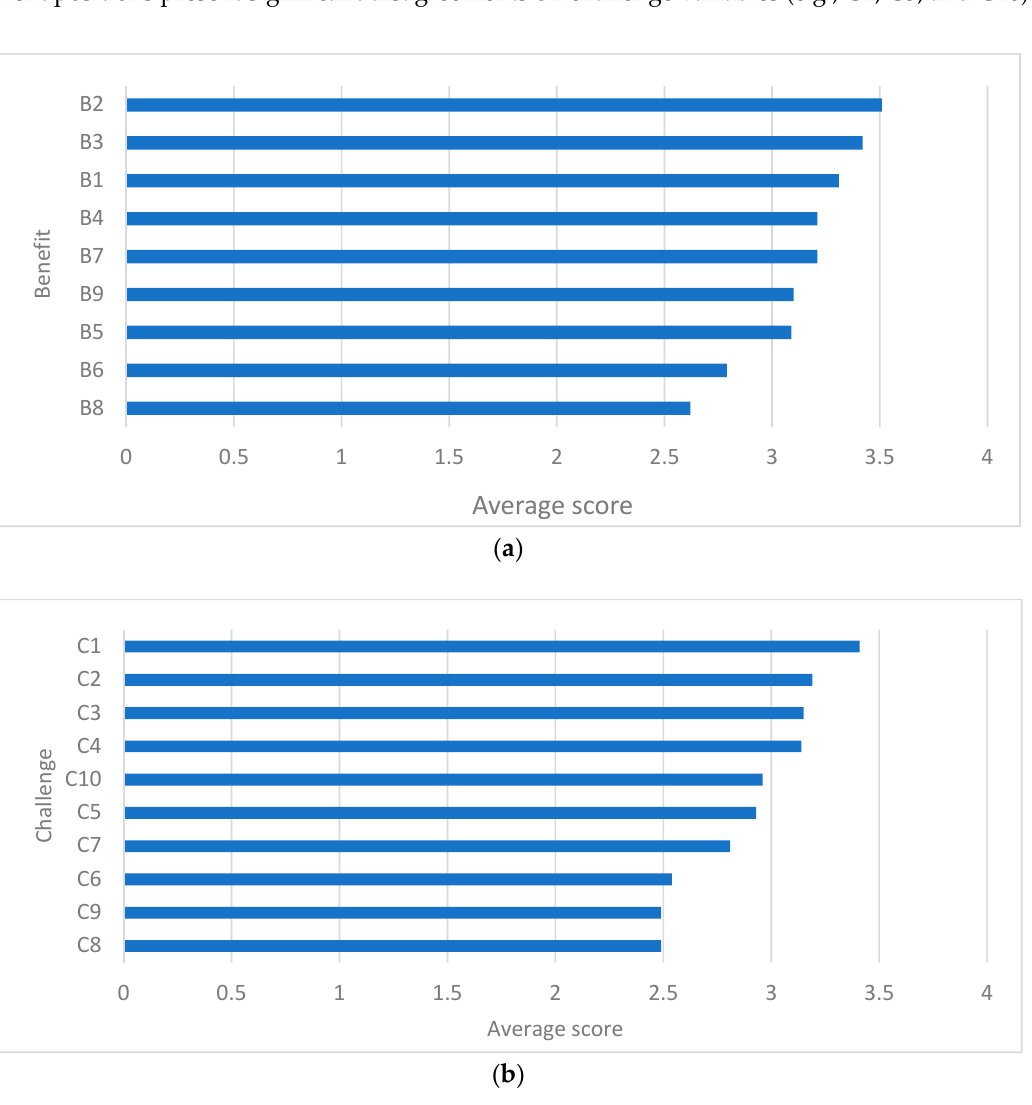
Figure 4. Average scores of ( a ) benefit variables and ( b ) benefit variables. 24